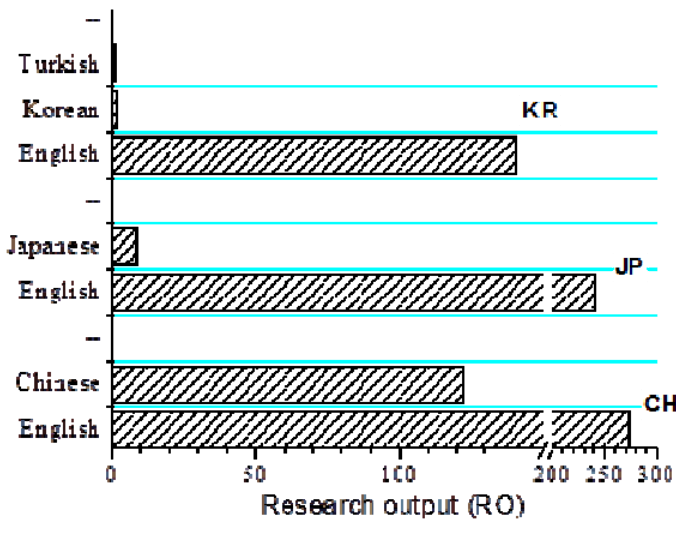
Figure 6. Increase in time of the world’s papers written in English, Chinese and Russian languages.